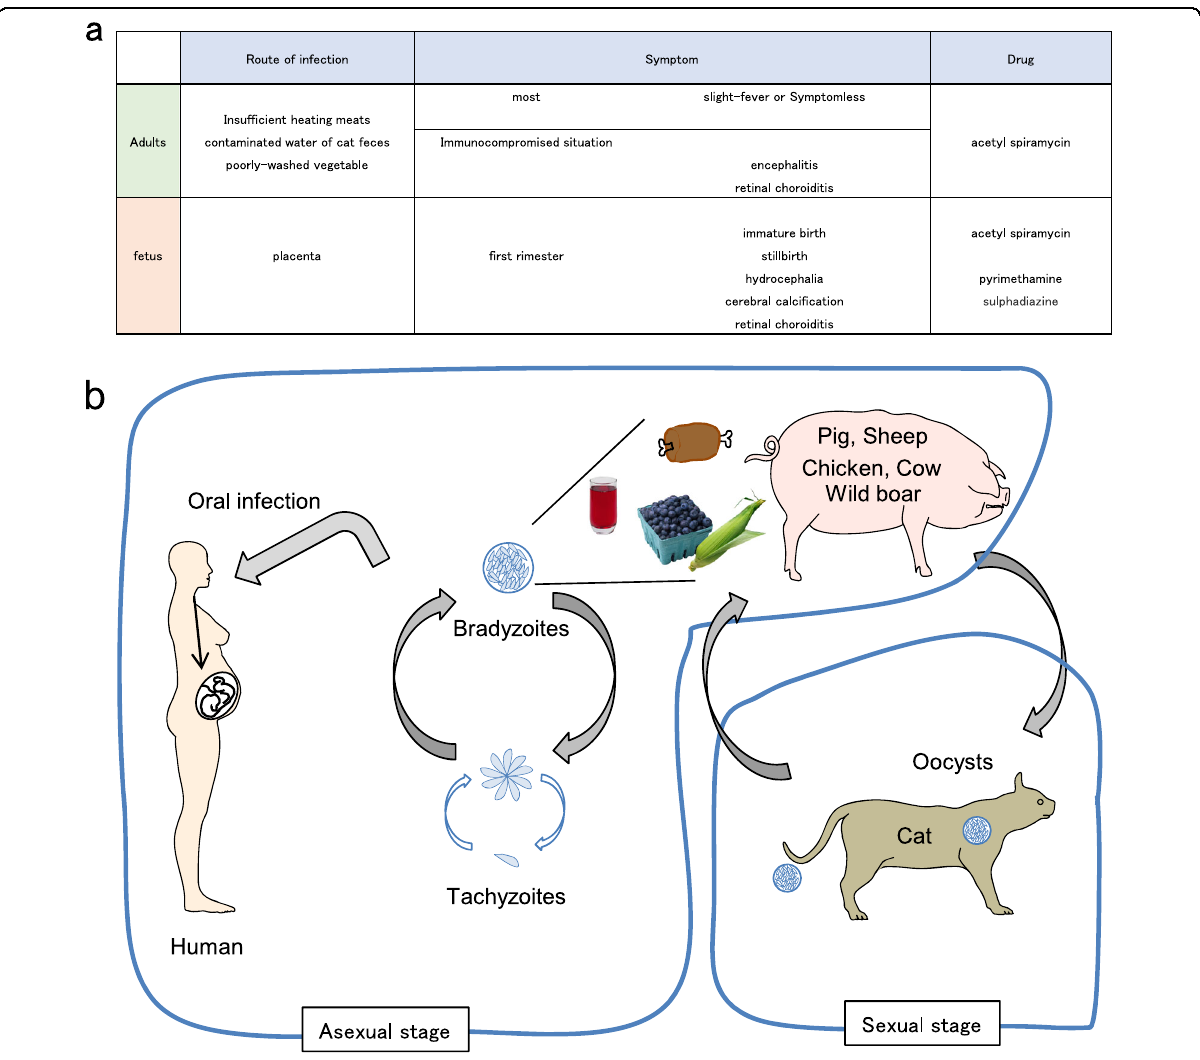
Fig. 1 Toxoplasmosis and the life cycle of T. gondii . a Symptoms following T. gondii infection in humans. b Life cycle of T. gondii . When infected with T. gondii , felines shed oocysts in feces into the environment. The oocysts contaminate water, soil, fruits and vegetables from gardens and are easily taken in by humans and other intermediate